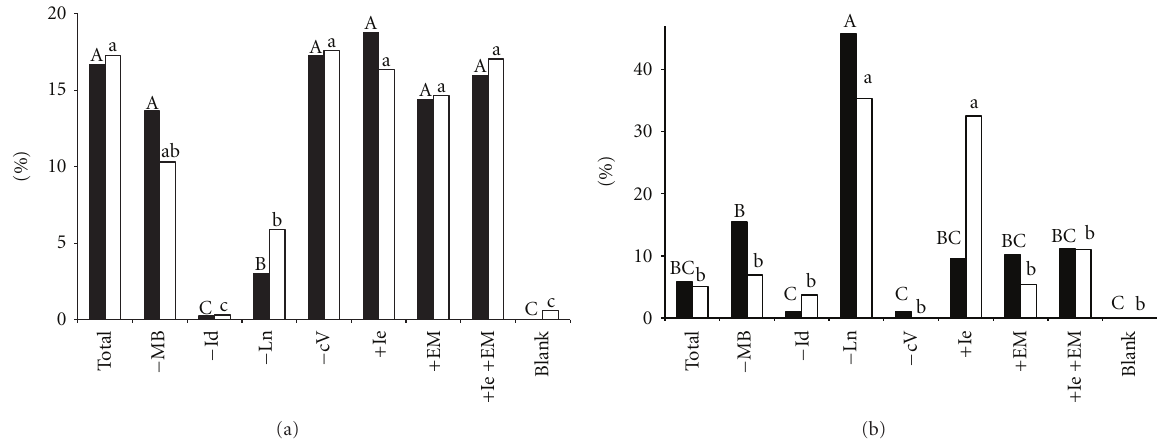
Figure 4: Percentage trap catches in a subtractive and additive field bioassay of I. avulsus -bait: (a) I. avulsus and (b) I. calligraphus . (for bait information, see Table 3). (cid:2) females; (cid:3) males. Bars with same letter are not significantly di ff erent. n = 7; total trap catches: I. avulsus 1673 ♀♀ , 795 ♂♂ ; I. calligraphus 209 ♀♀ , 135 ♂♂ .